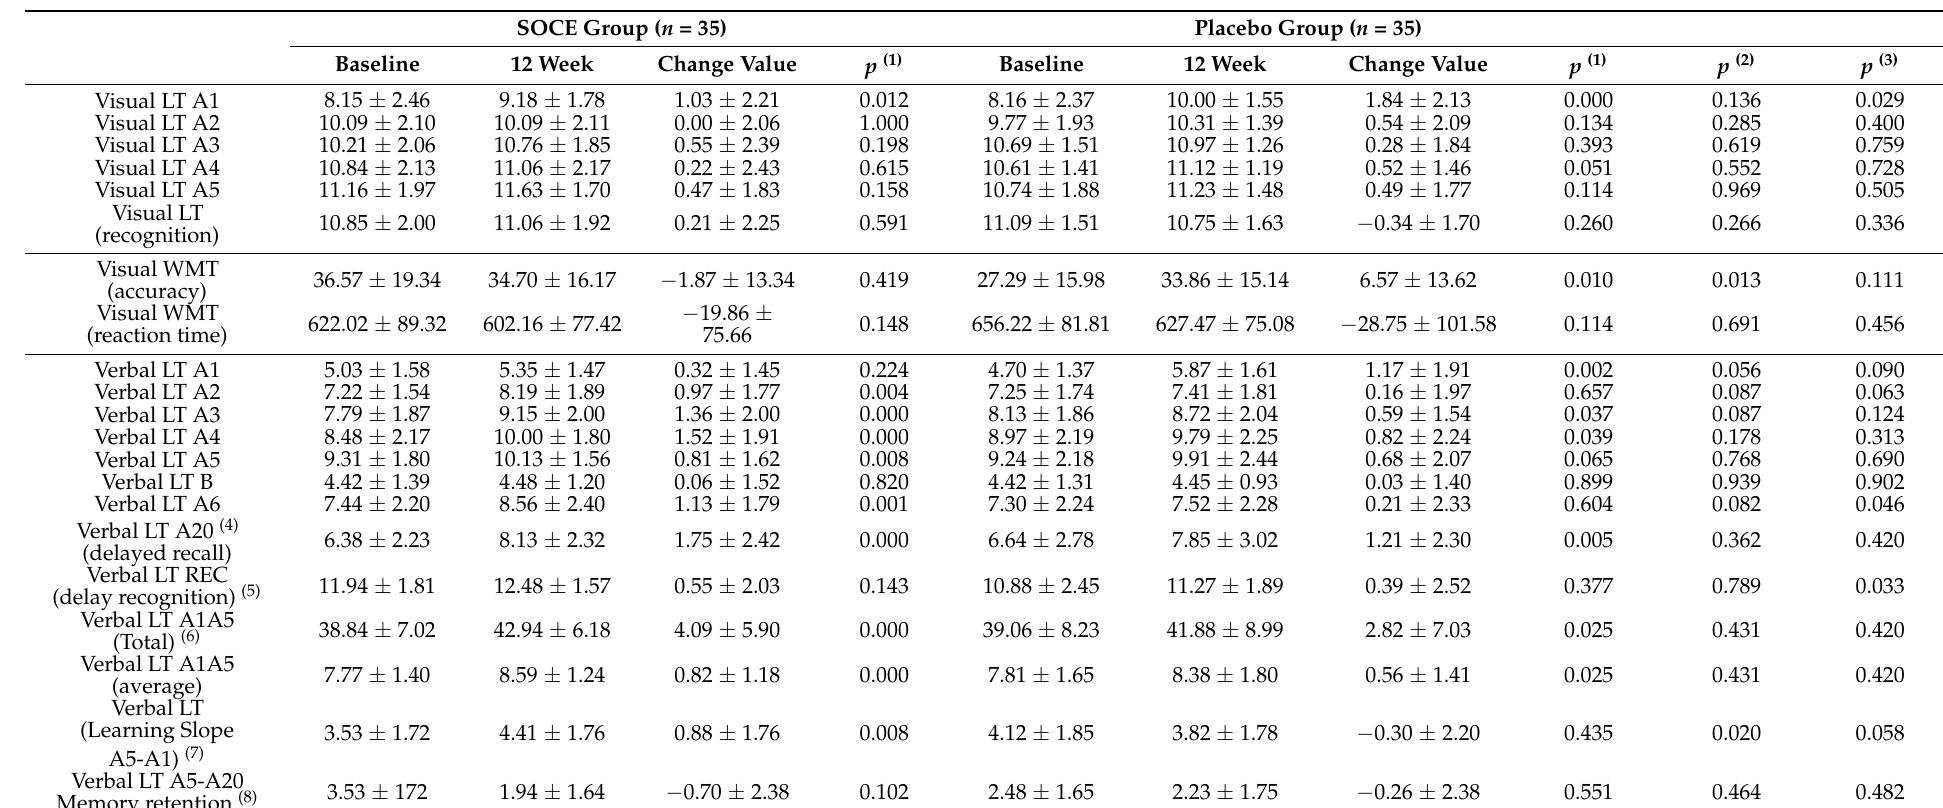
Table 3. Changes in neurocognitive function tests before and after 12 weeks of